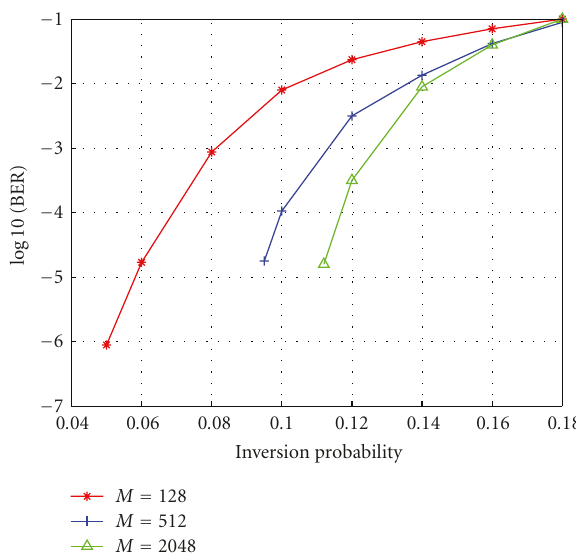
Figure 8: LDPC-CC decoding over the Gilbert-Elliott channel.